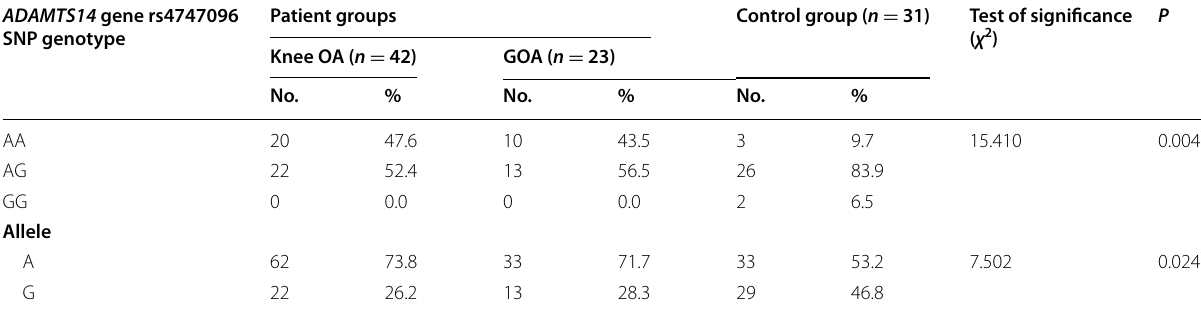
ADAMTS a disintegrin and metalloproteinase with thrombospondin motifs, GOA generalized osteoarthritis, No. , n number of patients or subjects, OA osteoarthritis, P P value for comparing between the studied groups, SNP single nucleotide polymorphism, χ 2 value of the chi-square test, % percentage of patients or control